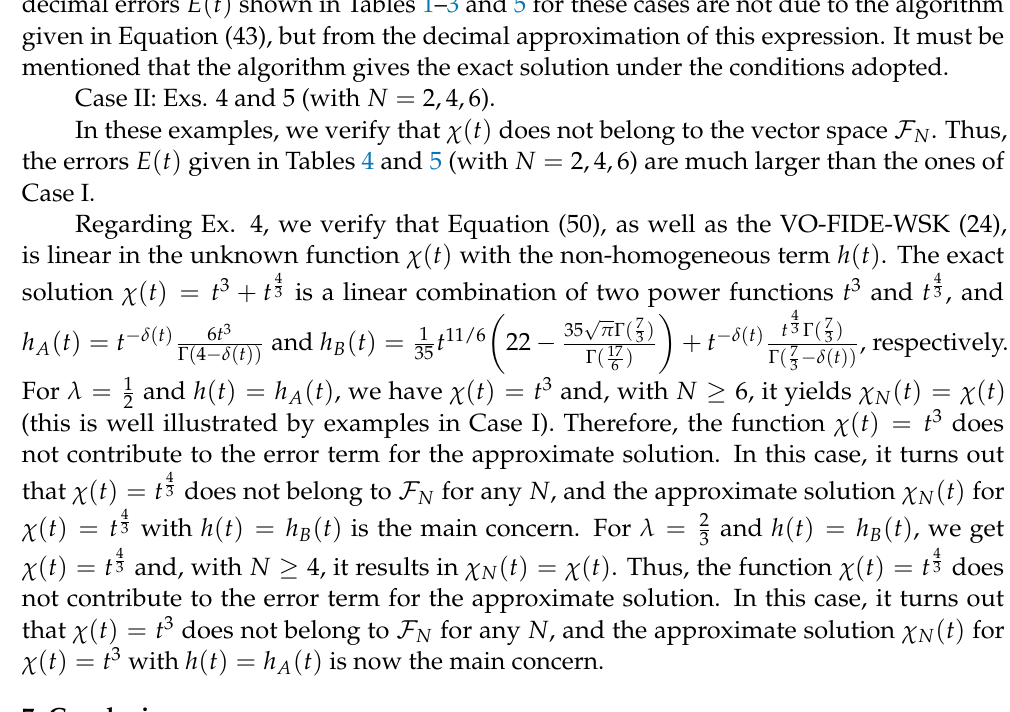
) , and δ ( t ) = t sin ( t ) , ( σ , ρ ) = ( 0, 1 2 2